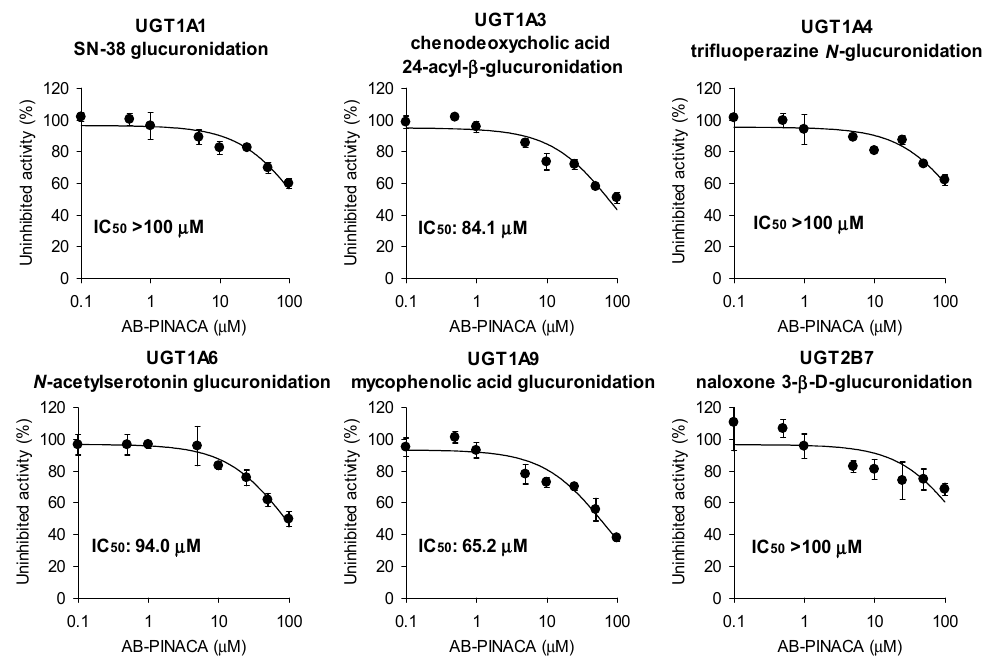
Figure 4. Inhibitory effects of AB-PINACA on metabolic activities of UGT1A1, UGT1A3, UGT1A4, UGT1A6, UGT1A9, and UGT2B7 in ultrapooled human liver microsomes. The cocktail UGT probes consist of A set (0.5 µM SN-38, 2 µM chenodeoxycholic acid, and 0.5 µM trifluoperazine) and B set (1 µM N -acetylserotonin; 0.2 µM mycophenolic acid, and 1 µM naloxone). Data are means ± SD ( n = 3).